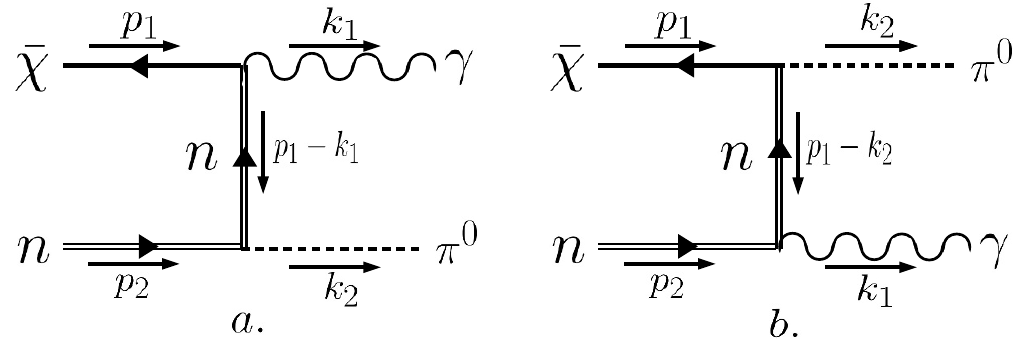
Figure 1 . Feynman diagrams for ¯ χ + n